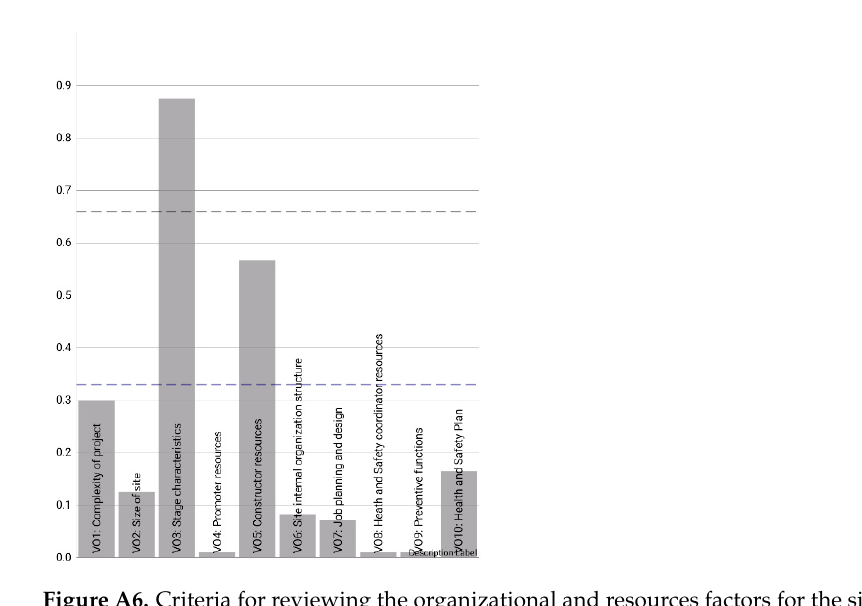
perimeter, etc.), the number of workers, the high ratio of other firm’s workers versus own workers.